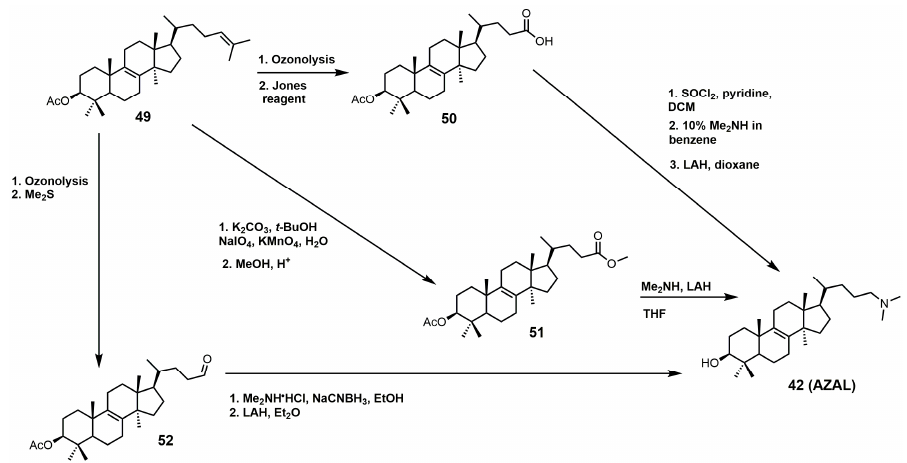
Figure 24. Three synthetic routes used to prepare 25-azalanosterol (AZAL).